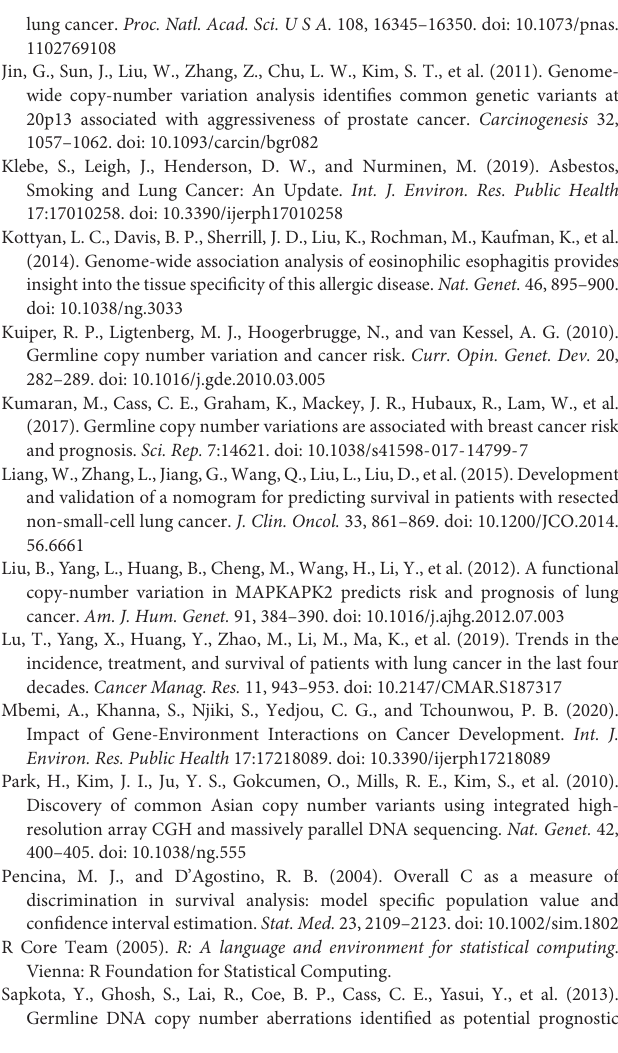
Supplementary Figure 1 | Genotyping of copy number of CNVR395.1 and CNVR2239.1. (A) The Accucopy assay was performed to determine the copy number of CNVR395.1 (left) and CNVR2239.1 (right). (B) The Taqman copy number assay was performed to determine the copy number of CNVR395.1 (left) and CNVR2239.1 (right). Supplementary Figure 2 | Agarose gel electrophoresis assay determining the existence of CNVR395.1 and CNVR2239.1. (A) Schematic representation of CNVR395.1 and PCR-amplified region of DNA with designed primers (Upper), and gel electrophoresis image for PCR bands (Below). (B) Schematic representation of CNVR2239.1 and PCR-amplified region of DNA with designed primers (Upper) and gel electrophoresis image for PCR bands